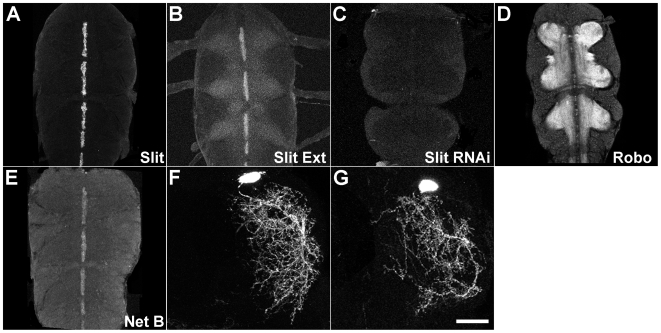
Localization of midline signalling molecules in the thoracic nervous system during the pupal-adult transition.(A) Detergent based antibody staining against Slit shows expression in midline cells at 48 h APF. (B) Detergent-free immunocytochemistry reveals robust extracellular Slit staining at the midline and within the developing neuropil at 48 h APF in the ventral nerve cord. (C) Conditionally removing Slit using RNAi. Following a knockdown of Slit, using Slit-GAL4 to drive UAS-Slit RNAi, we observed a lack of Slit staining in the developing neuropil using detergent-free immunocytochemistry. (D) Immunocytochemistry reveals Robo expression throughout all thoracic neuropils at 48 h APF. Note absence of staining at the midline. (E) Anti-myc staining reveals the localization of NetrinB in midline glia at 48 h APF, in a NetrinB-myc allele. (F) Ectopic expression of Robo::myc fusion protein in single-cell clone reveals that Robo can be localized in dendrites of leg motoneurons. (G) Ectopic expression of Fra::myc fusion protein in a single-cell motoneuron clone. Anterior is up. Scale bar applies to F and G = 20 µm.